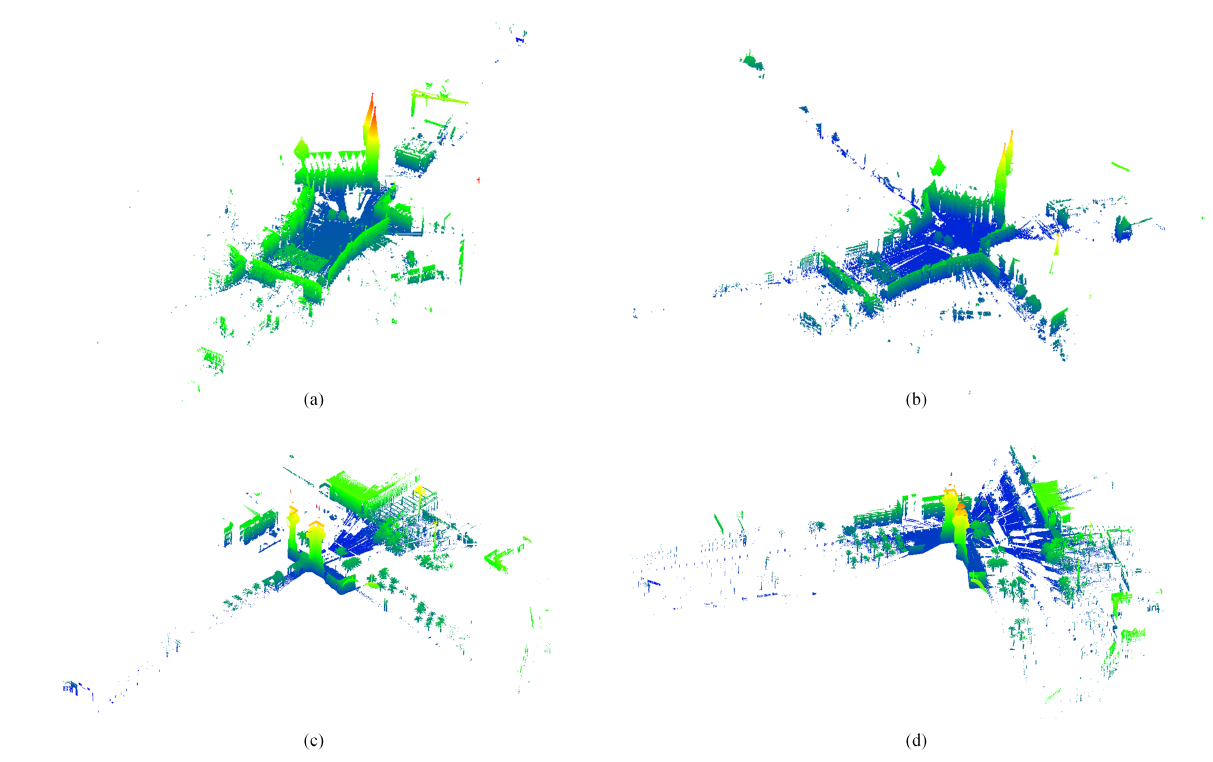
Figure 3. The experimental datasets. (a) and (b) are the source and target point clouds in the Bremen dataset. (c) and (d) are the source and target point clouds in the Resso dataset. (color coded with intensities).